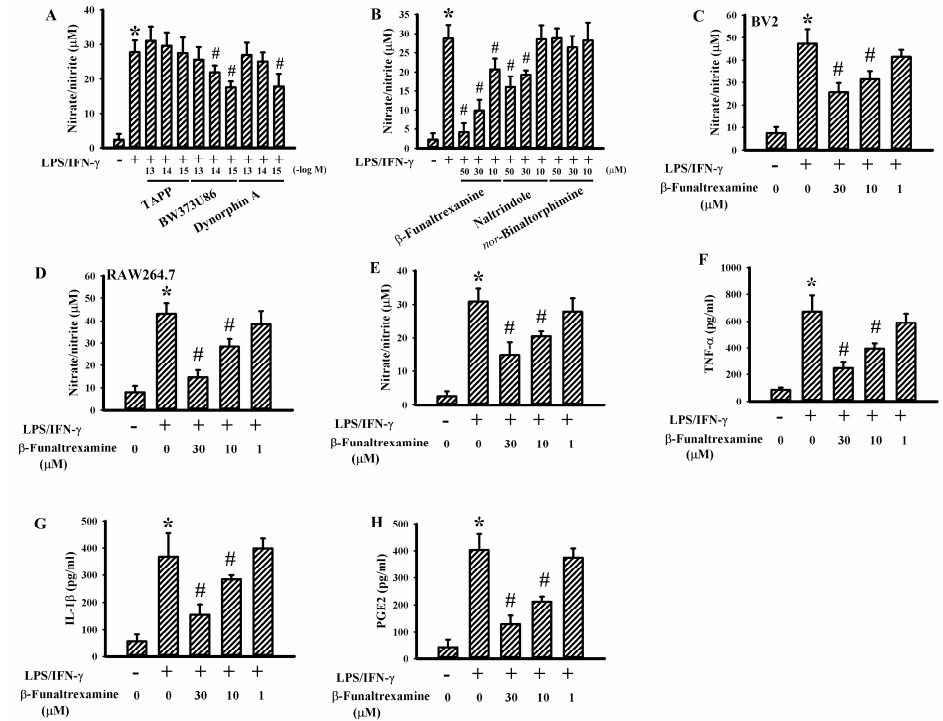
Figure 1. β -funaltrexamine alleviated neurotoxic cytokine production in neuron / glia cultures. Neuron /